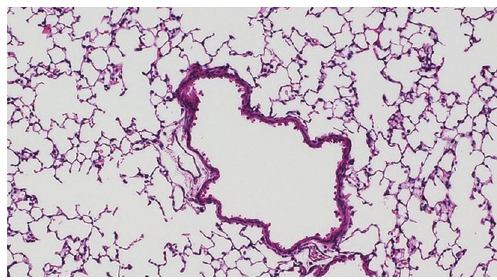
Figure 5: Lung parenchyma showing alveolar spaces and a large blood vessel. H&E